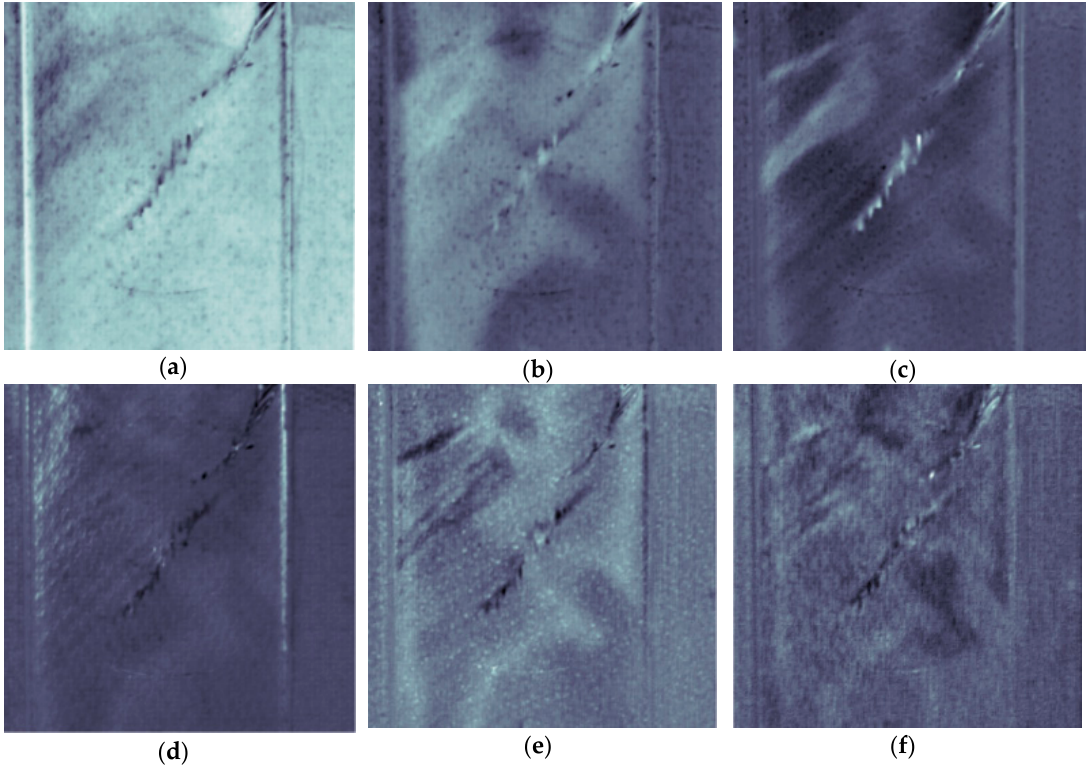
Figure 11. PCs extracted from a set of thermographic images collected from a composite material piece (side opposite to loading): ( a ) PC1; ( b ) PC2; ( c ) PC3; ( d ) PC4; ( e ) PC5; ( f ) PC6.